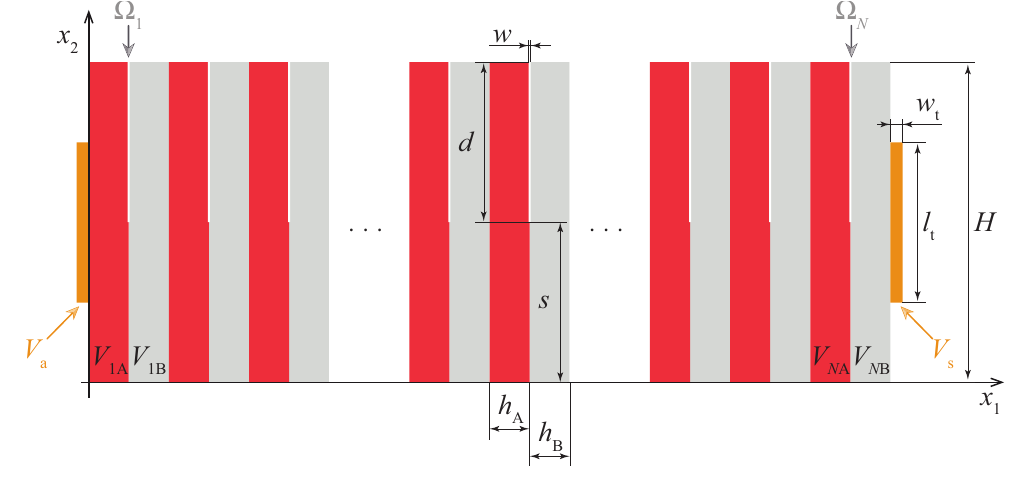
Figure 3. Geometry of the